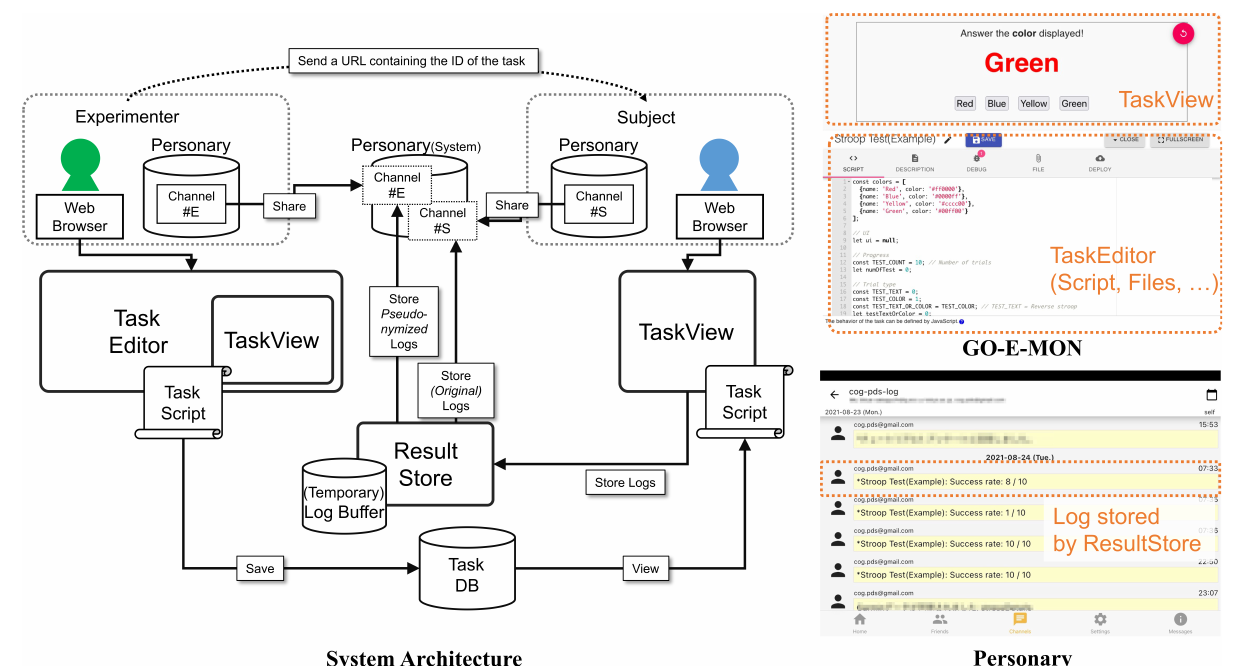
Figure 2. System Architecture and User Interface of GO-E-MON: The experimenter can define the behavior of a task as a script through the TaskEditor and distribute the URL to the subjects. Once the task is executed, the execution result is saved as experimental data in the Personary accounts of the experimenter and the subject. The data on the experimenter’s side is assigned a pseudonym ID, which can be used to identify the user in the